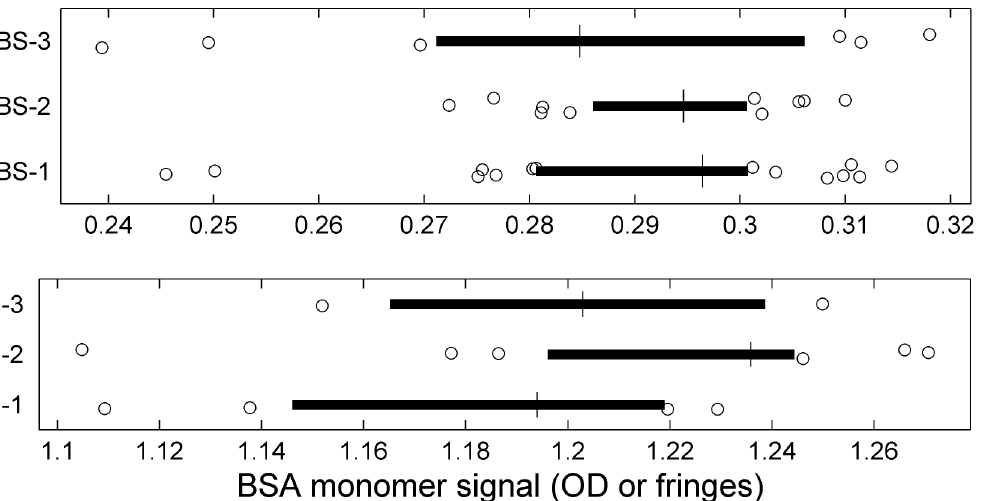
Fig 11. Distributions of calculated BSA monomer signals for the different kits and the different optical systems. The box-and-whisker plots indicate the central 50% of the data as solid line and draw the smaller and larger 25% percentiles as individual circles. The median for each group is displayed as vertical